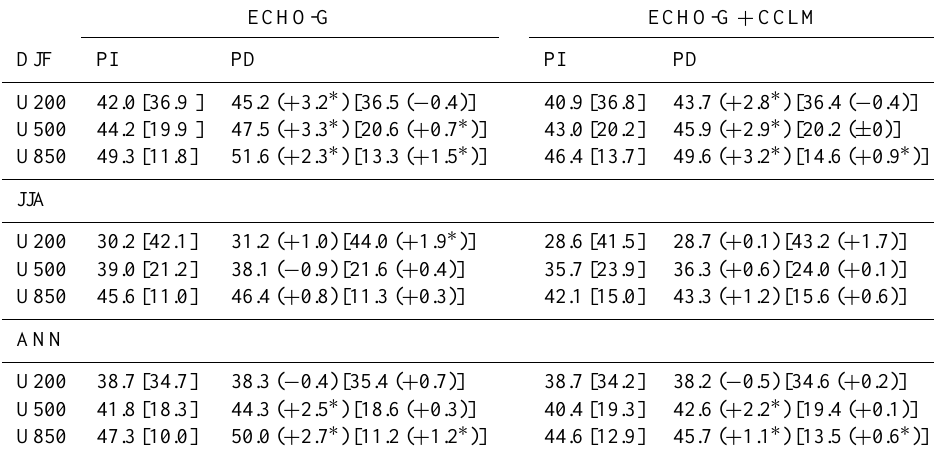
Table 3. Mean position ( ◦ S) (and intensity , ms − 1 ) of maximum zonal winds along 70 ◦ W for the pre-industrial (PI) and present-day (PD) simulation. The columns under ECHO-G display results for ECHO-G alone, the columns under ECHO-G + CCLM show results for the regional climate model simulation forced with ECHO-G. The difference to the pre-industrial simulation is given in parentheses. For the position, “–” indicates a more equatorward, “ + ” indicates a more poleward position during present-day period. The asterisk indicates values significantly different at the 5% level (two-sided test). DJF: December–February, JJA: June–August, ANN=annual